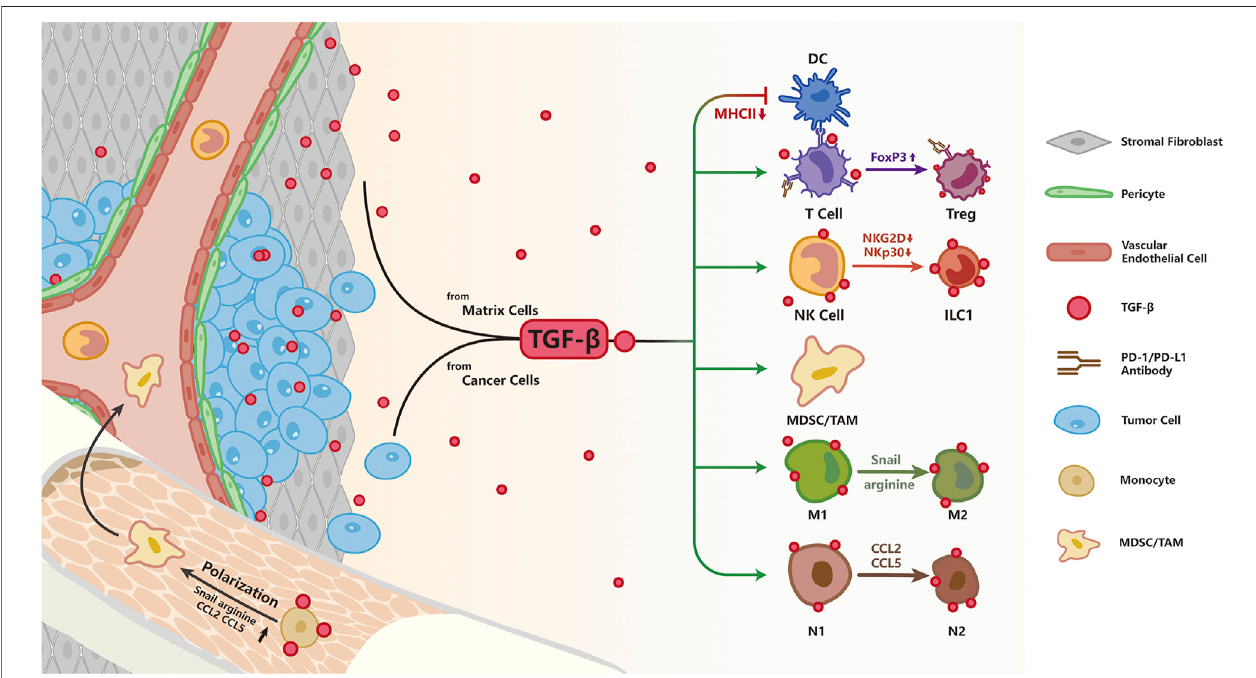
FIGURE 4 | TGF- β signaling and resistance to immunotherapy; As an immunosuppression cytokine, TGF- β is secreted by both tumor and stromal cells. TGF- β signaling pathway directly inhibits T cell function by up-regulating the expression of FoxP3, converting cytotoxic T cells to Treg cells to restrain immune response. Besides, TGF- β impairs NK function by down-regulation of NKG2D and NKp30, two surface receptors directing NK cells to eliminate abnormal cells. TGF- β impairs antigen presentation in DC cells by decreasing MHCII expression. TGF- β signaling pathway polarizes macrophages to the pro-tumorigenic M2 phenotype by increasing Snail, converts N1 neutrophils to an N2 phenotype by up-regulation of arginine, CCL2, CCL5, and facilitates expansion of MDSCs leading to enhanced immune tolerance.